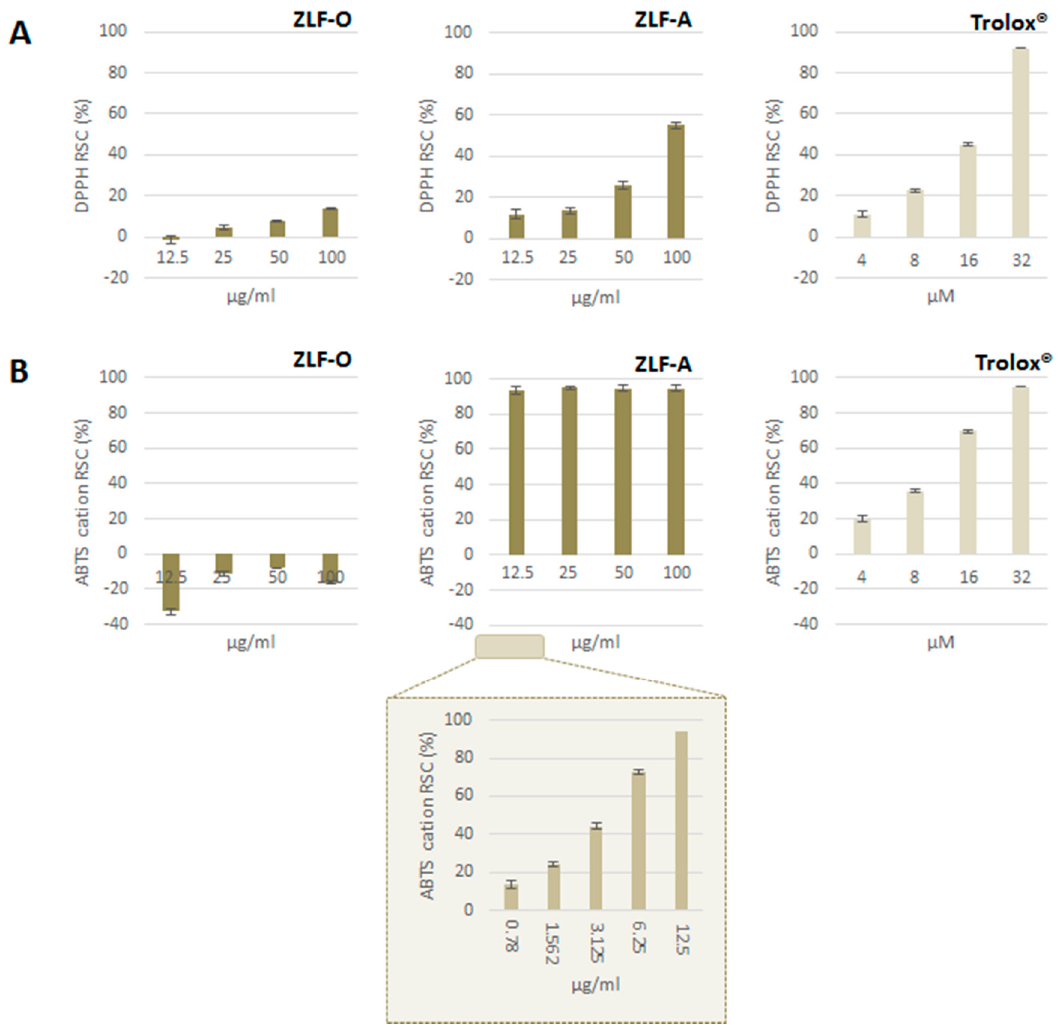
Figure 3. ( A ) DPPH • and ( B ) ABTS • + Radical Scavenging Capacity (RSC, %). Values, reported as percentage vs. blank, are the mean ± SD of measurements carried out on 3 samples (n = 3) analyzed three times.